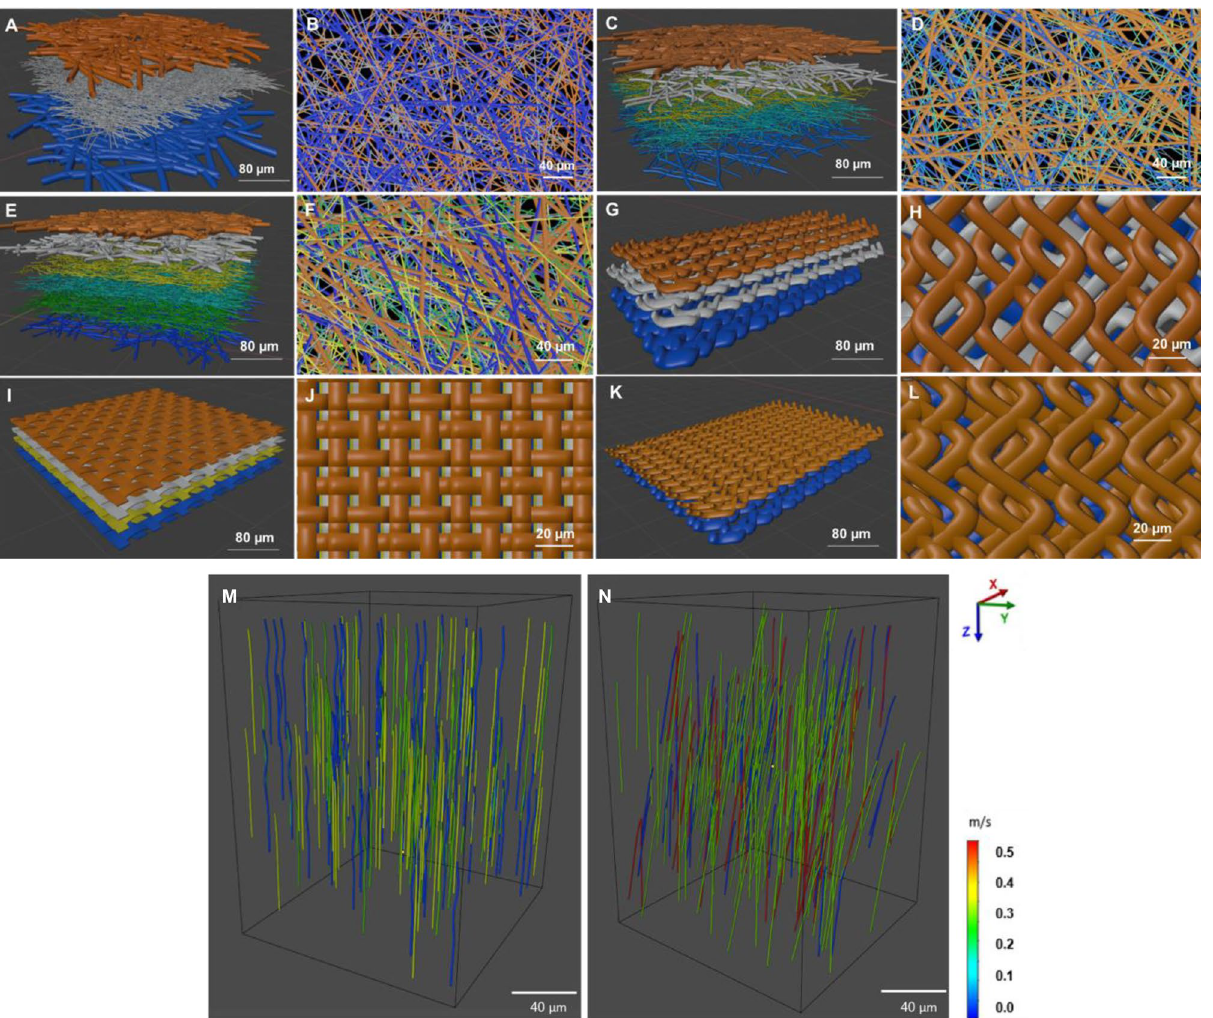
Figure 13. Simulation of fibre distribution of all layers for face masks: ( A , B ) surgical. ( C , D ) FFP2. ( E , F ) FFP3. ( G , H ) reusable cotton. ( I , J ) antiviral. ( K , L ) silk. The velocity streamline appears in the z-direction for the layers of two face masks: (M) surgical and (N)